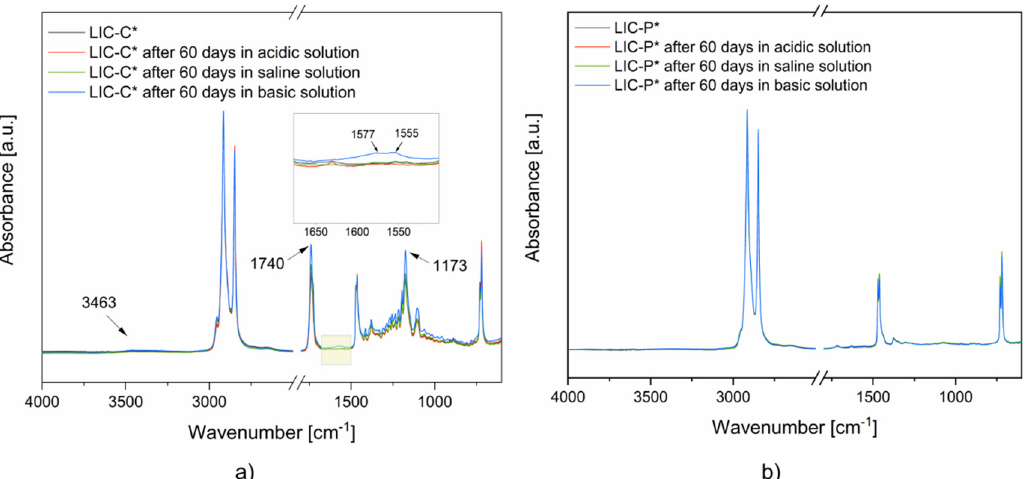
Figure 11. FTIR spectra of LICs surfaces after ageing in different environments: ( a ) LIC-C*, and ( b ) LIC-P*. The regions of the spectra are highlighted by yellow boxes when chemical modifications are detected.